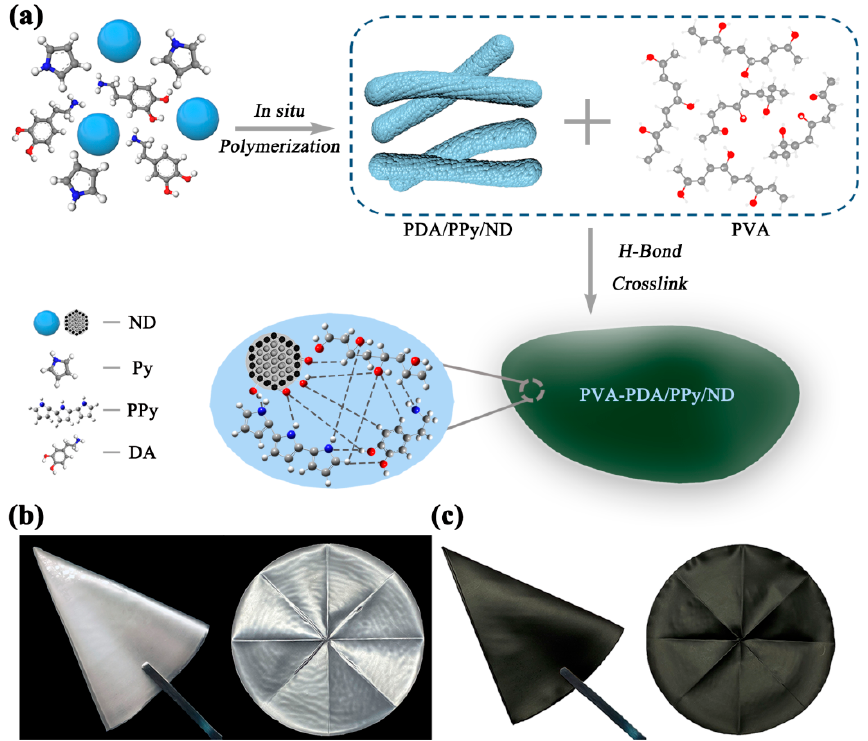
Figure 7. ( a ) Design diagram for PDA/pPy/ND film, using PVA as a film-forming aid and digital photos of ( b ) PVA film without adding PDA/pPy/ND; ( c ) PDA/pPy/ND film.